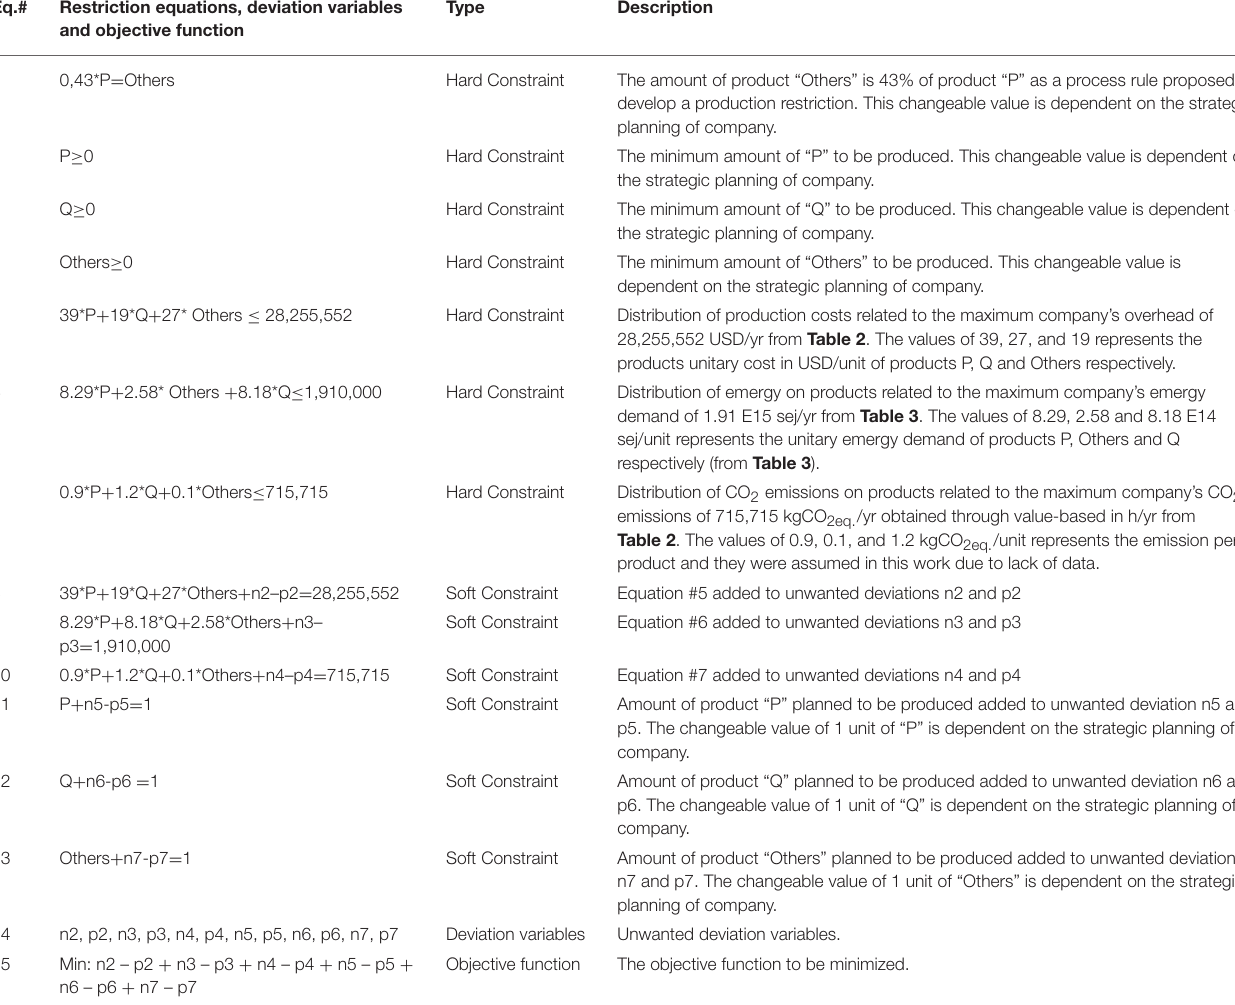
TABLE 5 | Description of the variables considered in modeling the final goal programming merging the three ABCs approaches a . Eq.#